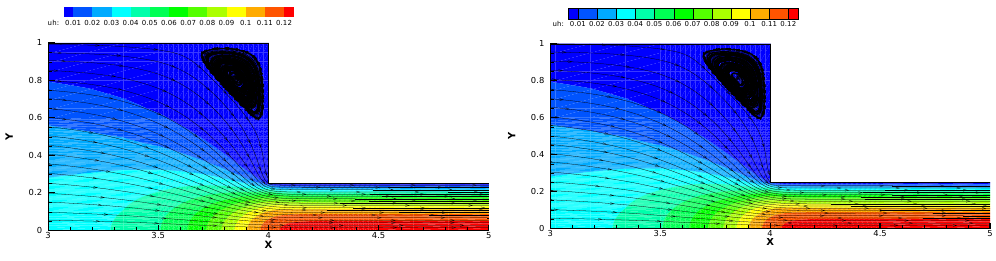
Figure 4. Streamlines and magnitude of velocity contours u for two-level method: steady state viscoelastic fluid flow model ( left ), Oseen viscoelastic fluid flow model ( right ).